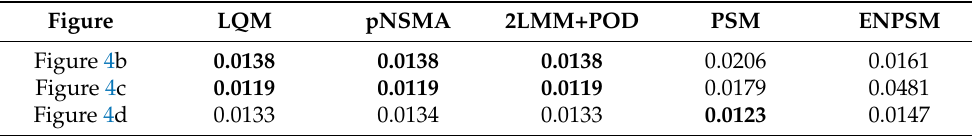
Table 5. RE results delivered by five unmixing method over Figure 4b–d with endmembers derived by means of maximum volume simplex analysis (MVSA) extraction algorithm [17]. The best results are highlighted in